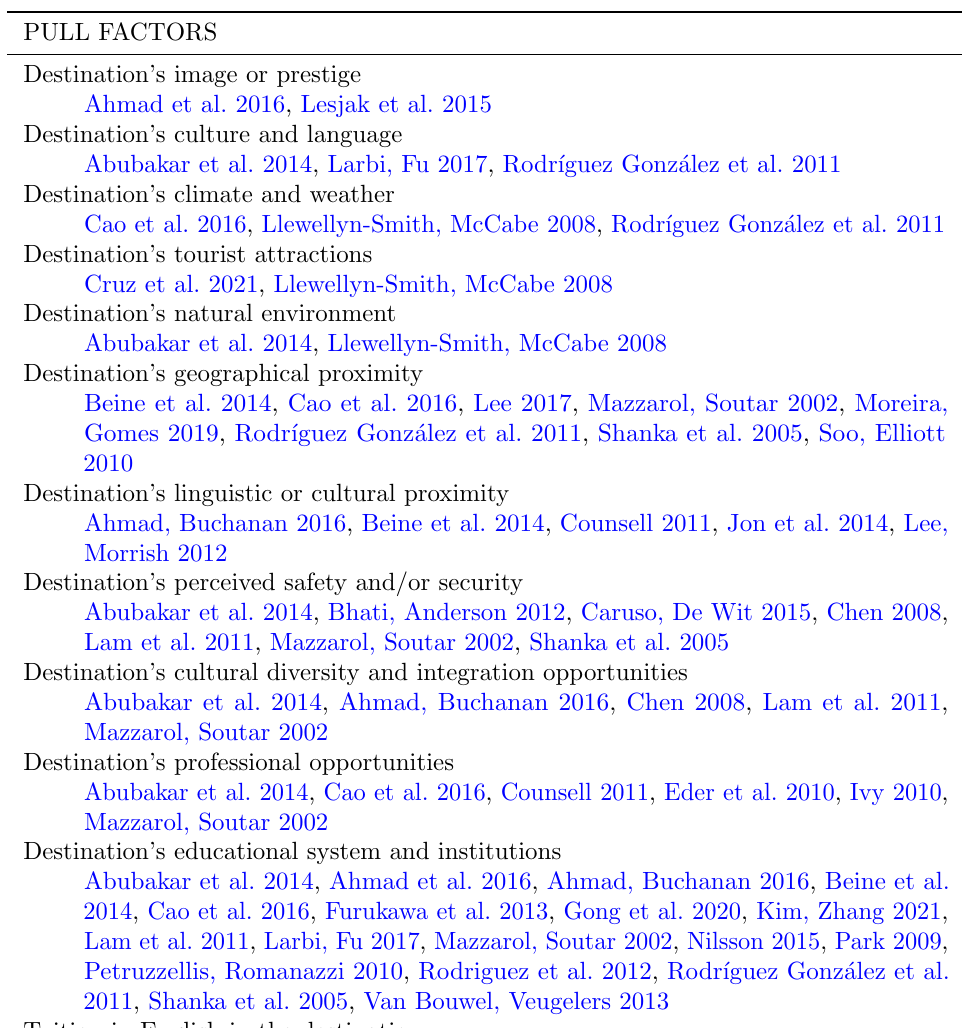
Table 2: Pull factors in international academic